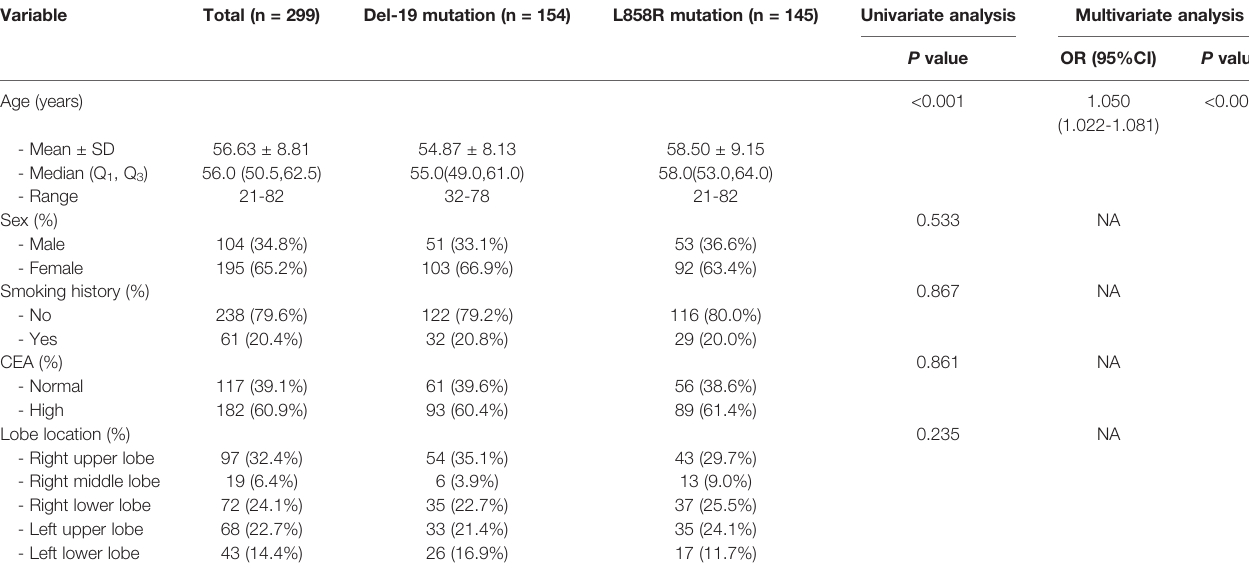
TABLE 3 | The relationship between clinical variables of patients and EGFR molecular subtypes (Del-19 mutation vs. L858R mutation) in the training set. Variable Total (n =